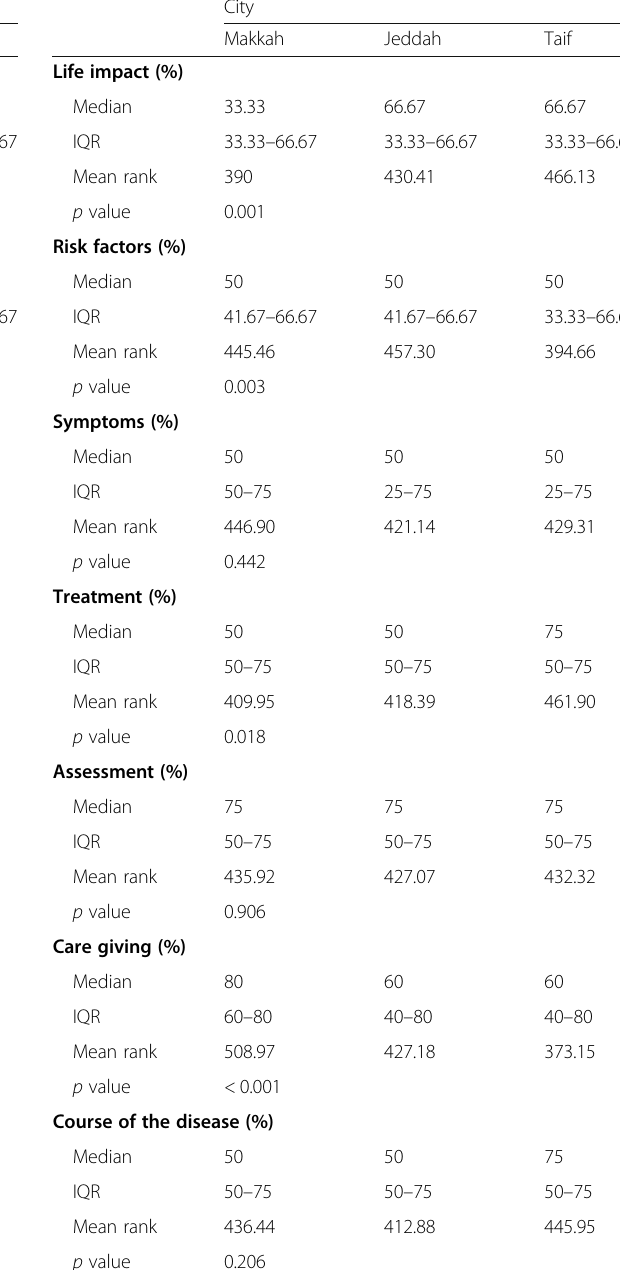
Table 6 Knowledge of different aspects of Alzheimer ’ s disease according to participant ’ s years of education